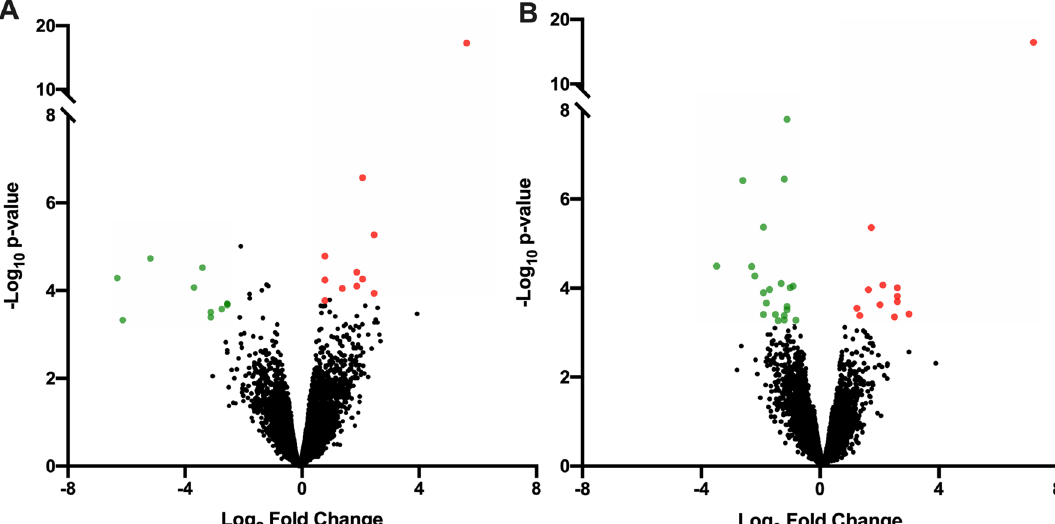
Figure 1. Volcano plot of differentially expressed genes in subcutaneous WAT and gluteus medius skeletal muscle tissues of pre-weaned dairy calves. Differential gene expression in the ( A ) adipose and ( B ) muscle tissues of pre-weaned dairy calves supplemented with 5-hydroxytrytophan (5-HTP, 90 mg/day; n = 4) or saline (CON, 8 mL saline; n = 4). The y-axis displays the − log10 P-value for each gene, while the x-axis displays the log 2 fold change for that gene relative to 5-HTP. Red dots indicate upregulation and green dots indicate downregulation in the 5-HTP group (FDR ≤ 20%); black dots indicate non-significance or FDR ≥